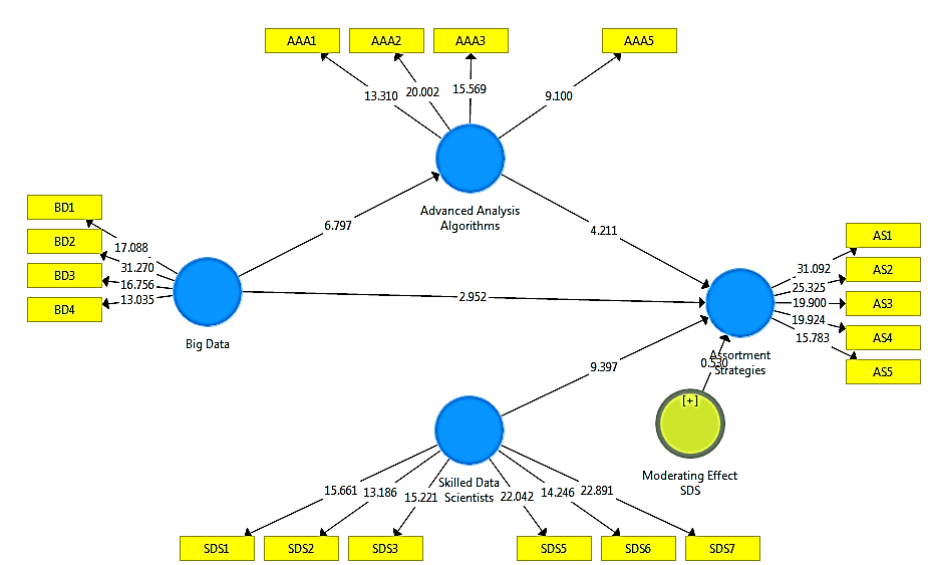
Figure 3: Discriminant